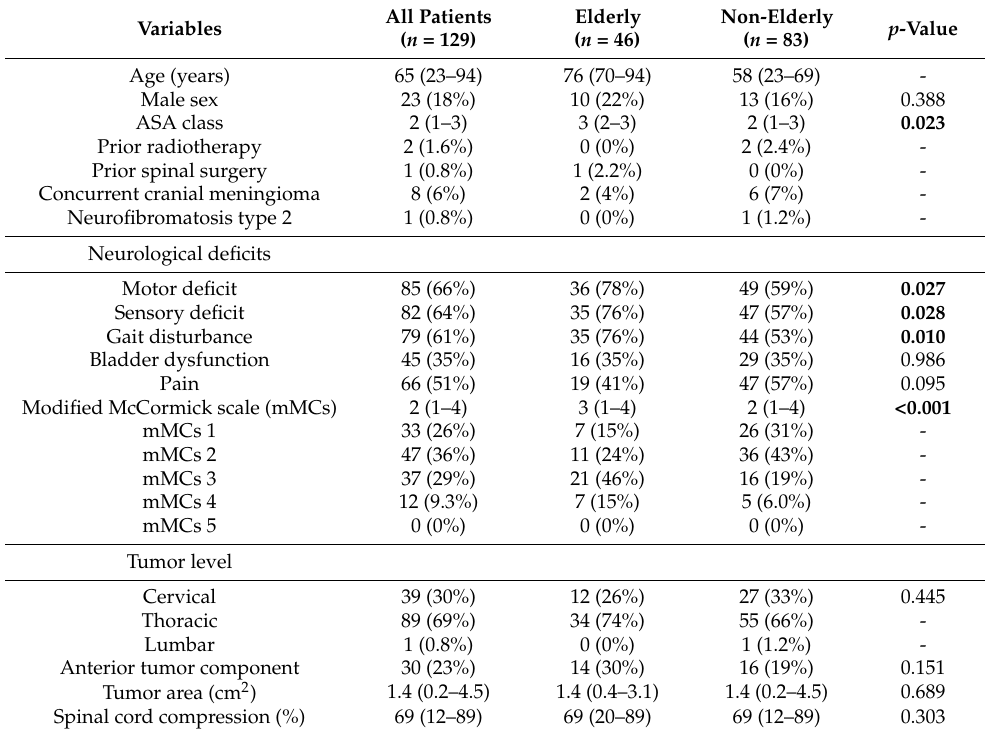
Table 2. Baseline data.